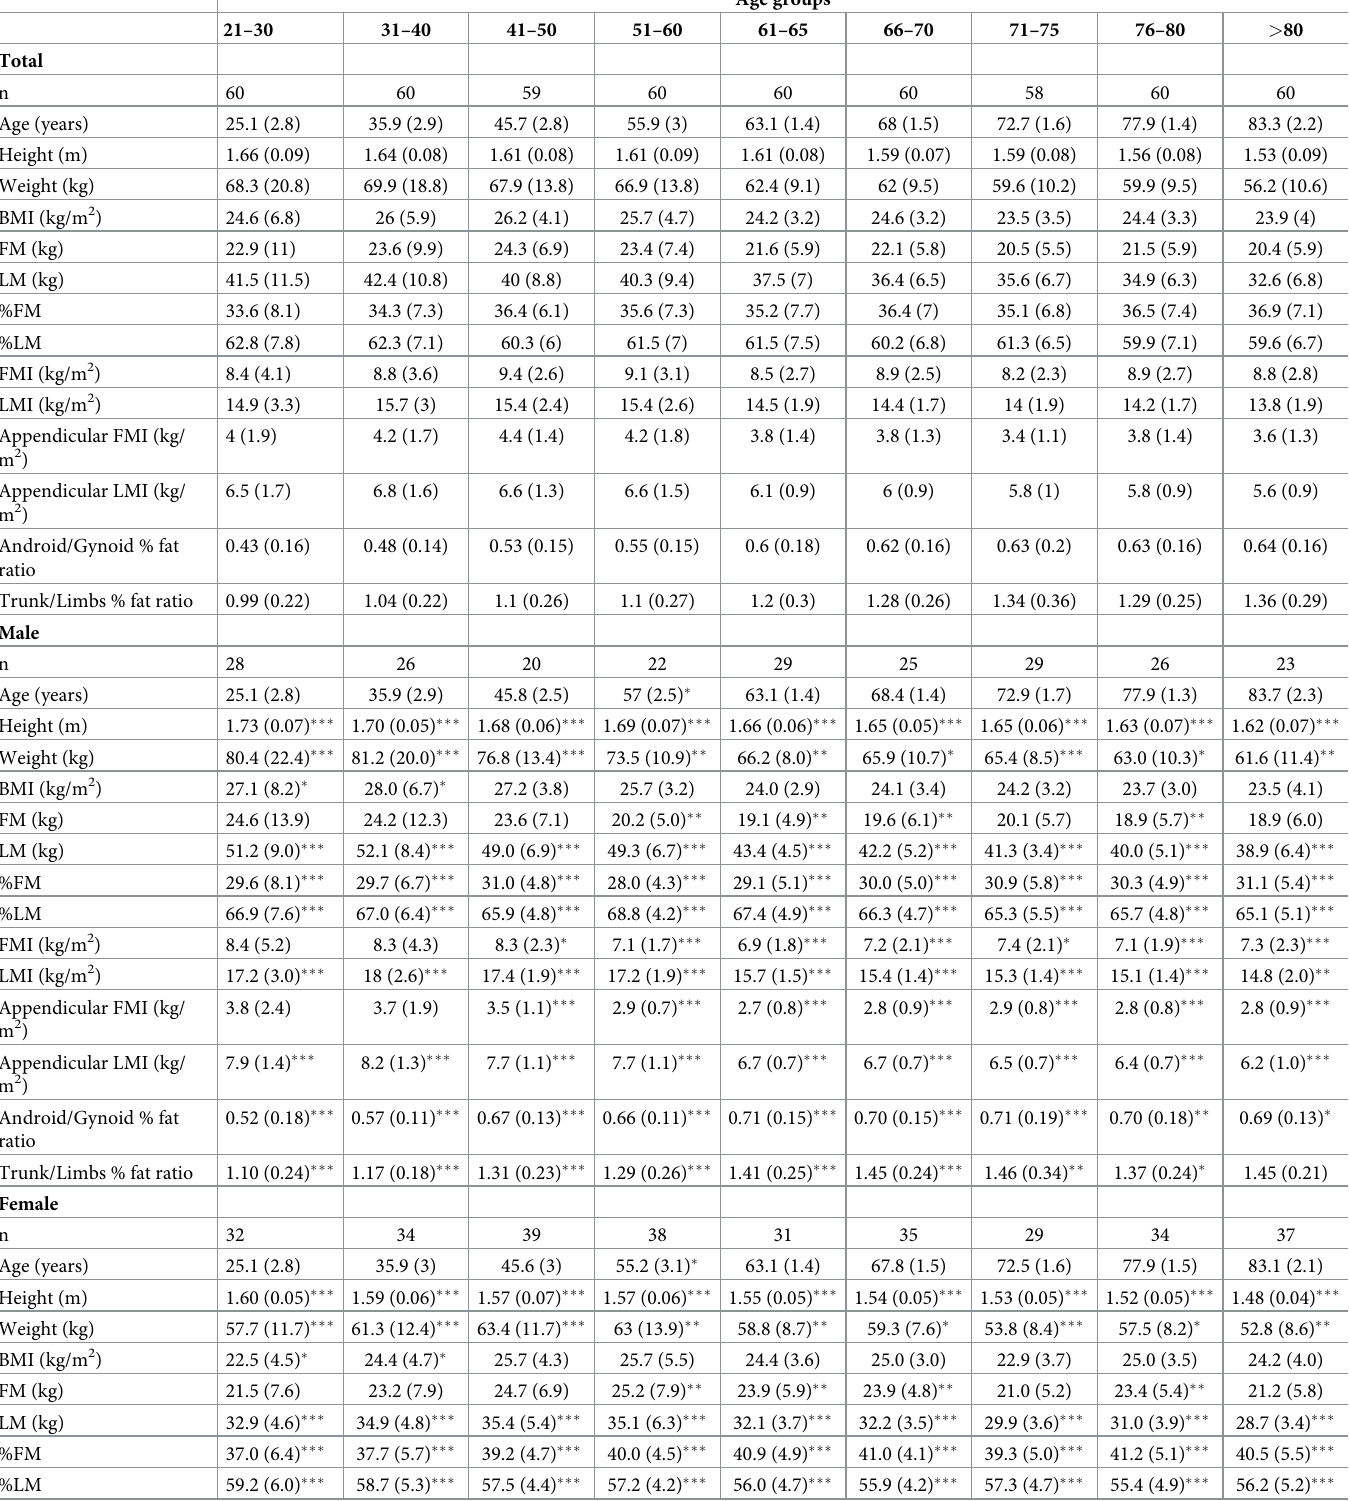
Table 1. Mean (SD) of baseline participant characteristics stratified by age groups for overall, male and females